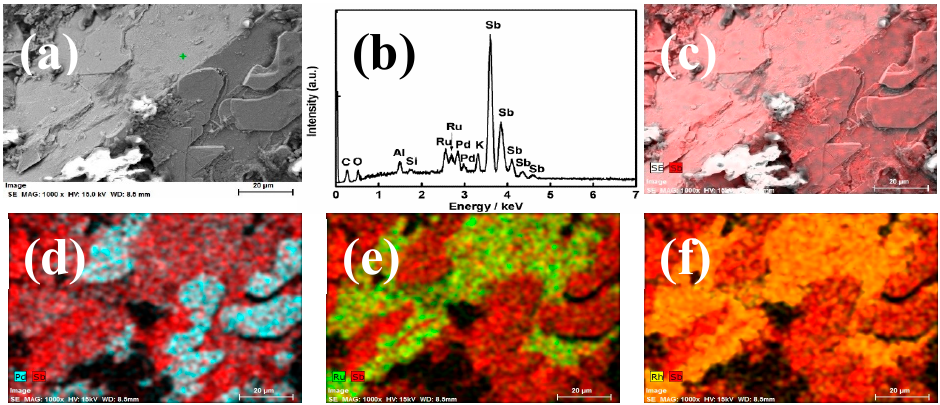
Figure 2. ( a ) FE-SEM images, ( b ) EDS analysis for the Sb metal obtained from the batch 1 and the corresponding elemental mapping: ( c ) Sb; ( d ) Pd and Sb; ( e ) Ru and Sb; ( f ) Rh and Sb.